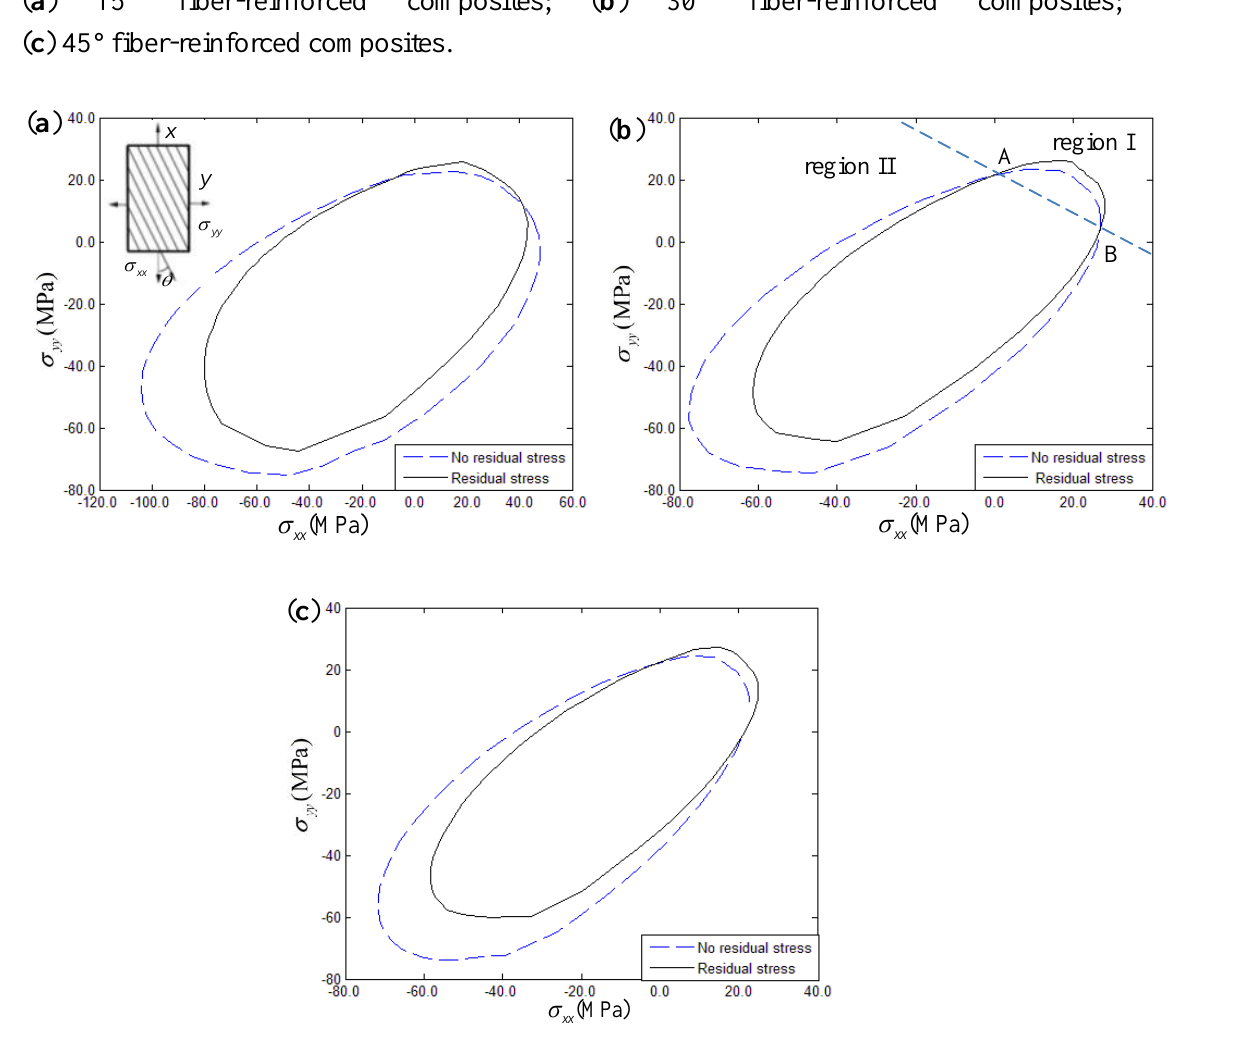
  yield surface of xx yy